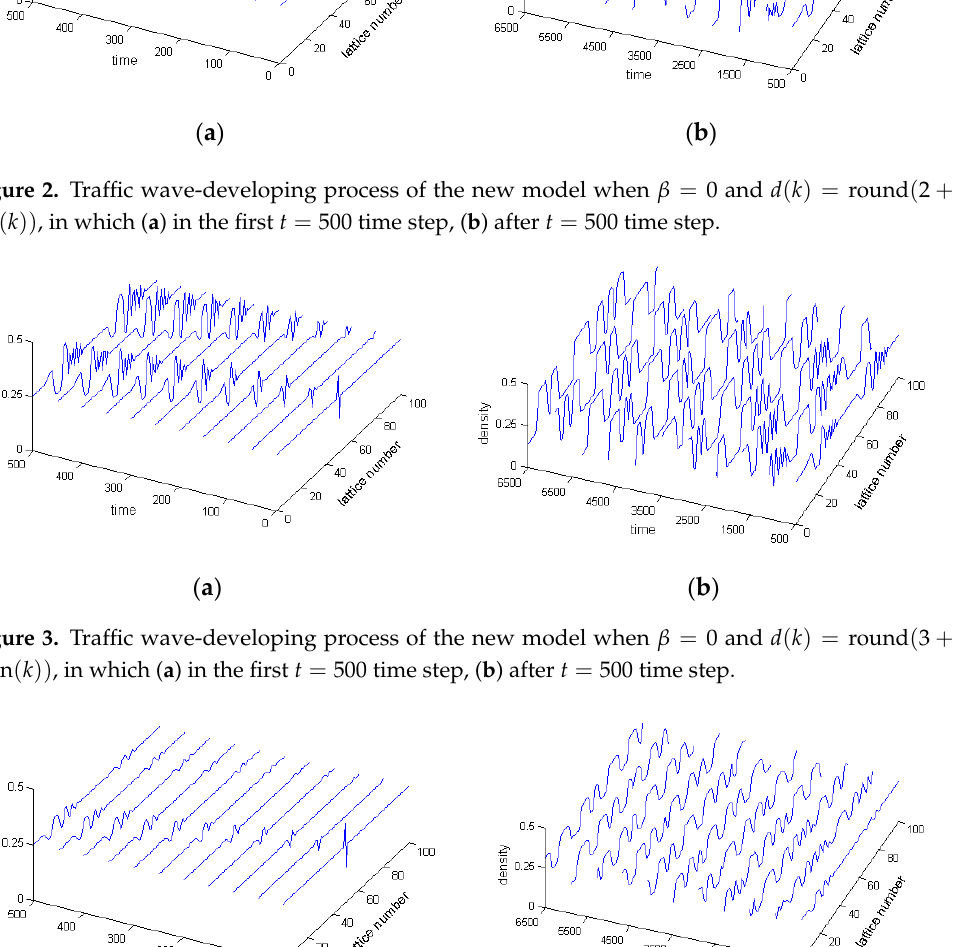
( a ) ( b ) ( a ) ( b ) ( a ) ( b ) Figure 4. Traffic wave-developing process of the new model when =0.03  and Figure 4. Traffic wave-developing process of the new model when β = 0.03 and d ( k ) = round ( 3 + Figure 4. Traffic wave-developing process of the new model when =0.03  and Figure 4. Traffic wave-developing process of the new model when =0.03  and ( )=round(3+2sin( )) d k k , in which ( a ) in the first =500 t time step, ( b ) after =500 t time step. 2sin ( k )) , in which ( a ) in the first t = 500 time step, ( b ) after t = 500 time ( )=round(3+2sin( )) d k k , in which ( a ) in the first =500 t time step, ( b ) after =500 t time step. ( )=round(3+2sin( )) d k k , in which ( a ) in the first =500 t time step, ( b ) after =500 t time step.